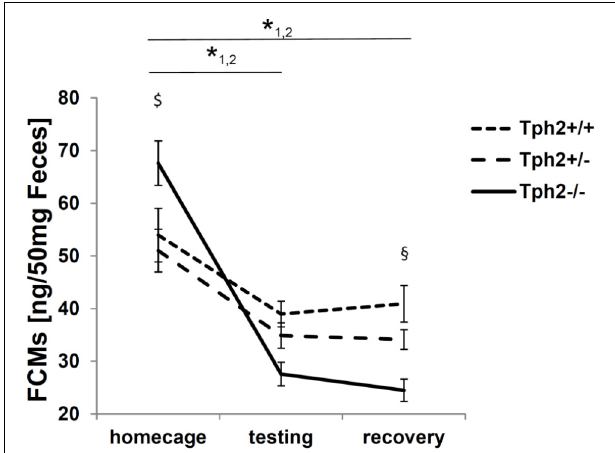
FIGURE 2 | Fecal corticosterone metabolites (FCMs) in 50 mg feces. 1 p < 0.05 for home cage compared to testing and recovery in tryptophan hydroxylase 2 (TPH2)-deficient mice ( Tph2 − / − ). 2 p < 0.05 for home cage compared to testing and recovery in Tph2 + / − . $ p < 0.05 Tph2 − / − compared to Tph2 + / − under home cage conditions. § p < 0.05